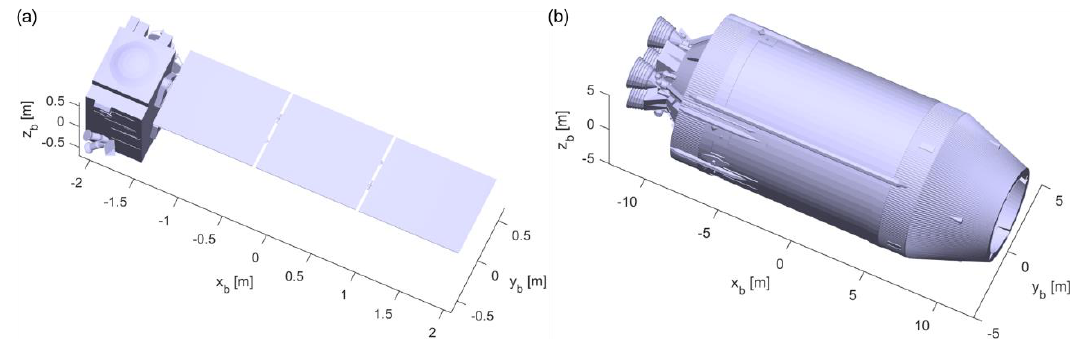
Figure 2. 3-dimentionl images of ( a ) defunct satellite, and ( b ) rocket body.